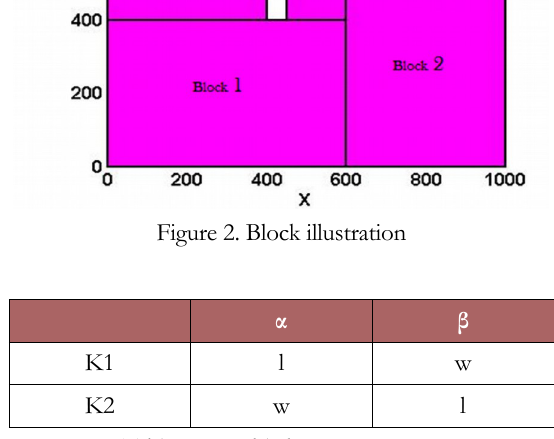
Table 1. Possible box